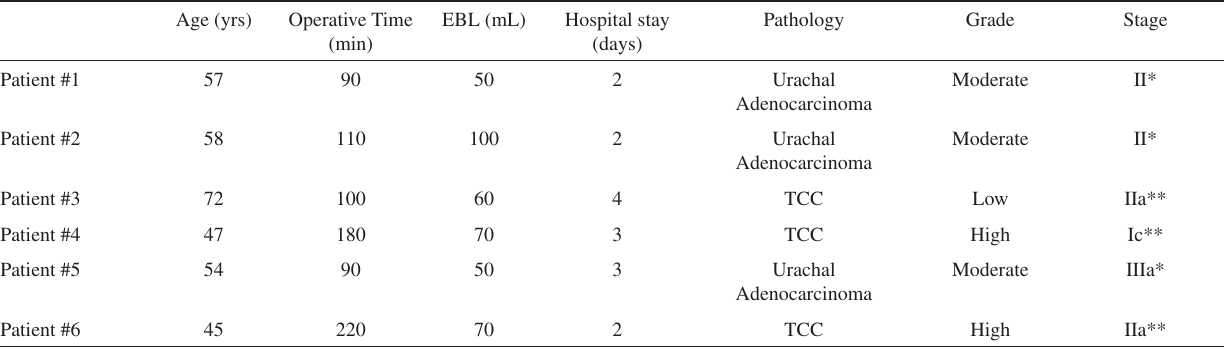
Table 1 - Perioperative and pathological